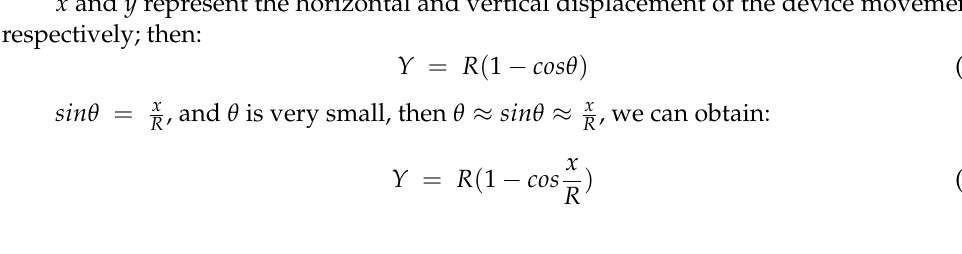
Figure 5. The simple calculation of SMA negative stiffness hyperboloid bearing.